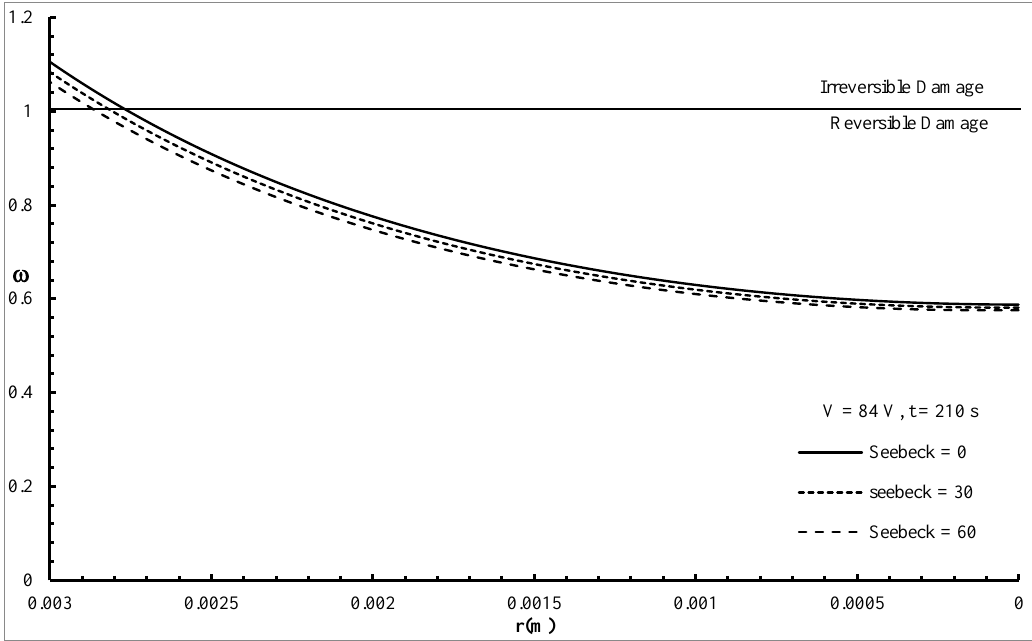
Figure 19 . The thermal damage distribution of lipoma tumor with various values of the Seebeck Figure 19. The thermal damage distribution of lipoma tumor with various values of the Seebeck R   . coefficient when 1300 coe ffi cient when R e = 1300 Ω e